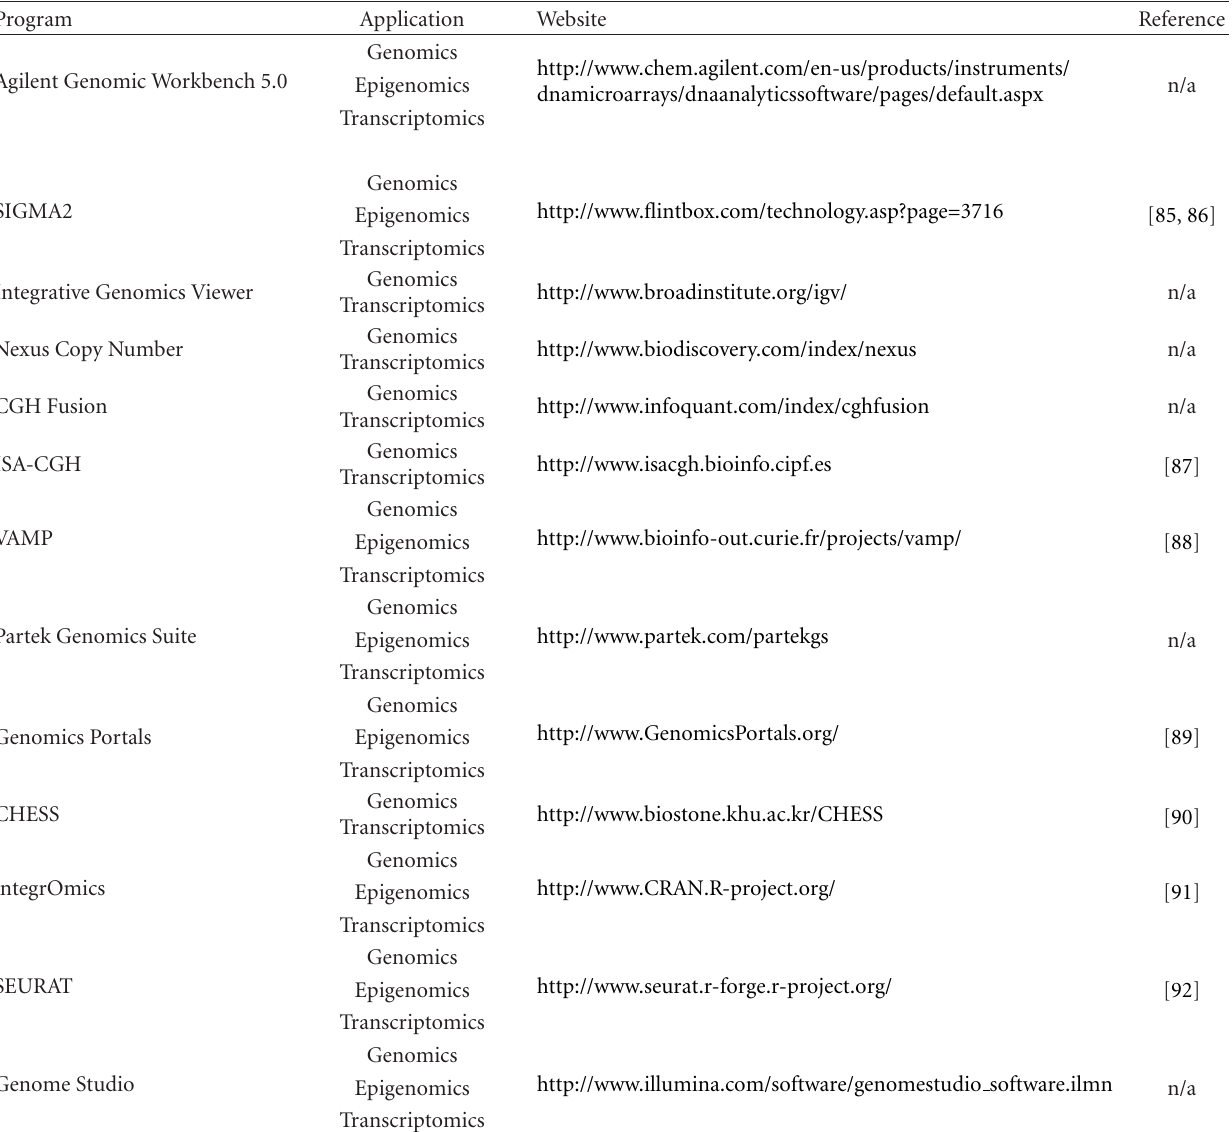
Table 3: Software for integrative analysis of Multidimensional omics